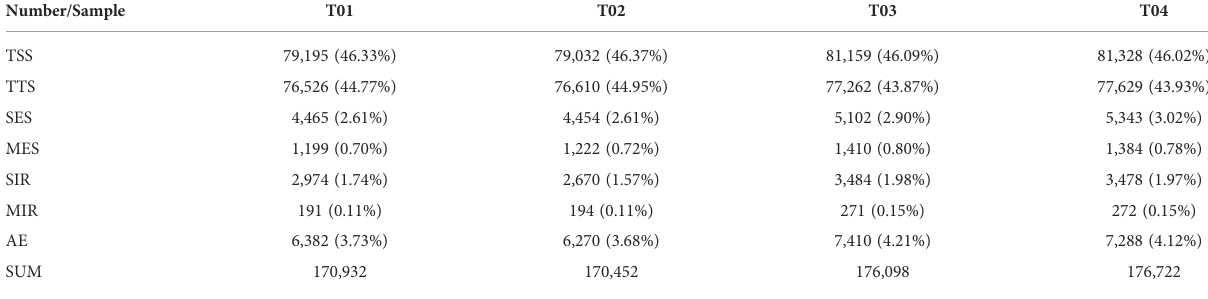
TABLE 2 Number and type of alternative splicing.